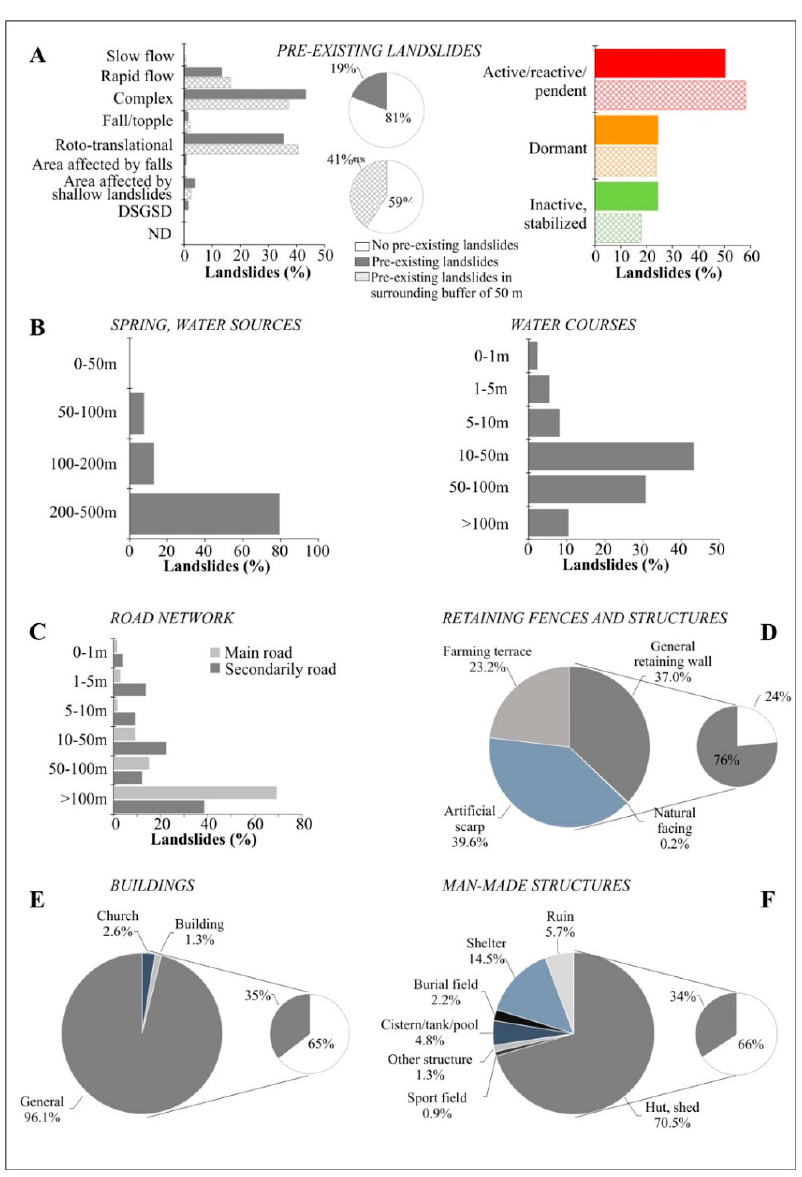
Figure 10. Statistical distribution of landslides regards to the geomorphological, hydrological and anthropic settings of the Entella catchment area: ( A ), pre-existing landslides; ( B ), drainage patterns, including springs and watercourses; ( C ), road network; ( D ), retaining fences and structures; ( E ), buildings and ( F ) other man-made structures.